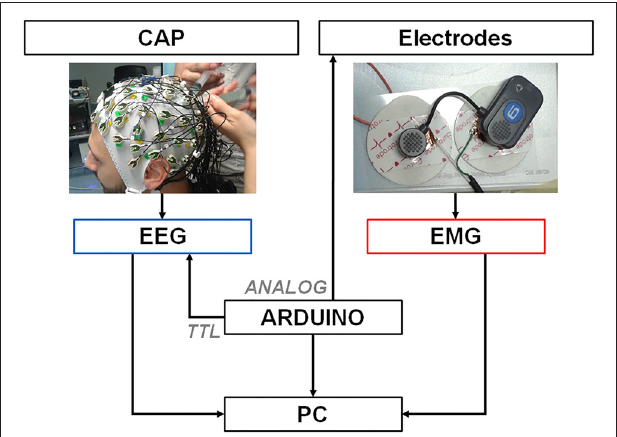
FIGURE 2 | Recording and synchronization platform. A PC is connected through a serial port to an Arduino Zero platform that simultaneously delivers digital TTL pulses (spikes) to the EEG amplifier and analog 3 mV – 4 ms pulses to one EMG electrode by means of a custom-designed cable. EEG and EMG signals collected by the electrodes are transmitted to the respective amplifiers that deliver the data to a PC for later offline synchronization.